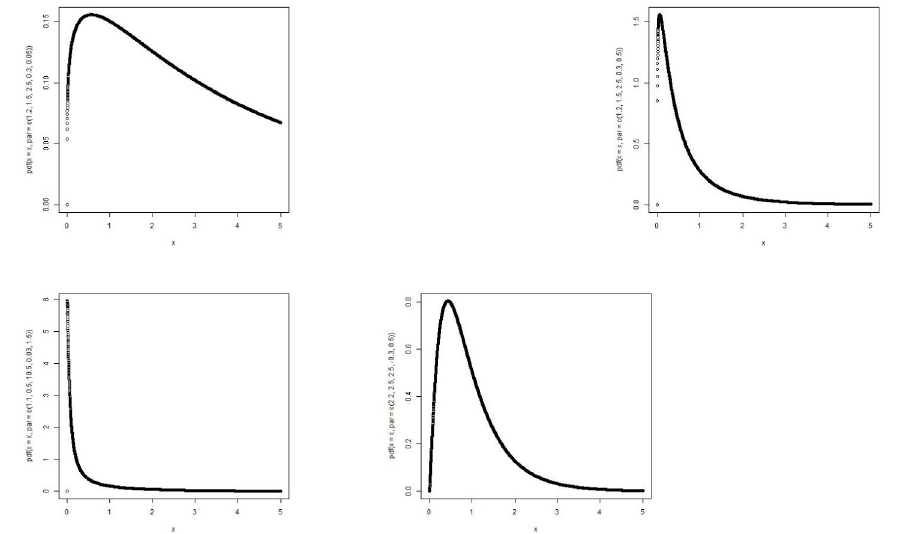
Fig 3. Graphs of p.d.f of MBTED with various parameter values.